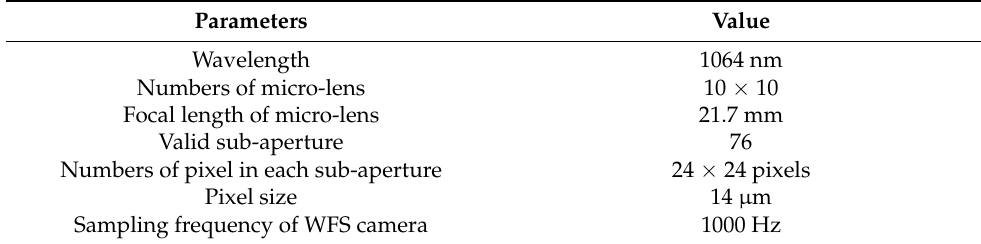
Table 1. The key parameters of the